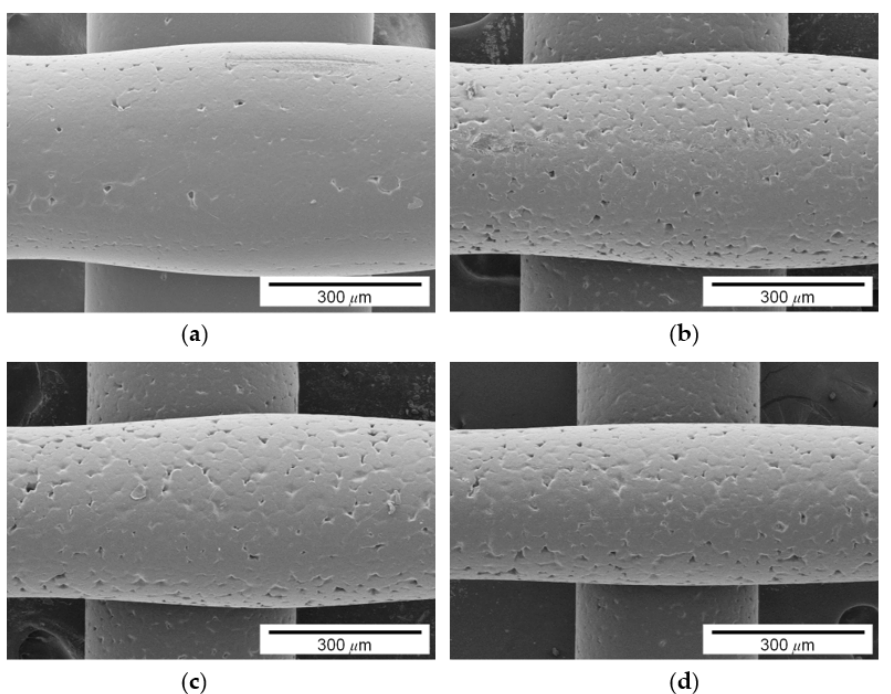
Figure 8. Surface morphology of the filaments with different pigment concentrations: ( a ) 0, ( b ) 5, ( c ) 10, and ( d ) 15 wt.%.